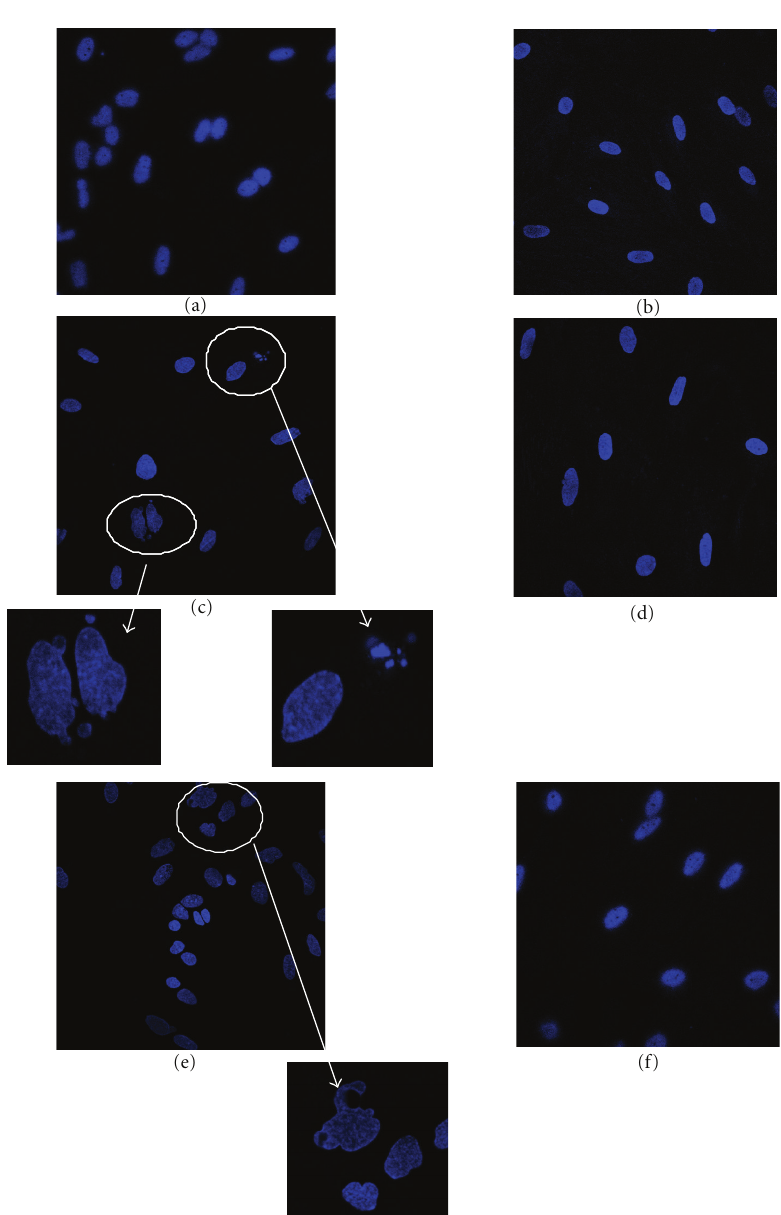
Figure 5: E ff ect of treatment with 5 μ M resveratrol on ethanol-induced nuclear damage in primary cultures of astrocytes. Nuclei were labeled with Hoechst 33342 as described in Section 2. Figure 5 shows representative fluorescent microscope images evidencing the nuclear morphology of astrocytes in control conditions (a), exposed to 5 μ M resveratrol for 3 days (b), exposed to 20mM ethanol for 3 days without (c) or with a recovery period (e), or exposed to 20mM ethanol for 3 days, with pre- and cotreatment with 5 μ M resveratrol (d) and followed by a recovery period (f). In zoom sections of micrographs, arrows point nuclear blebs and nuclear fragmentation. All images are representative fields of at least three independent experiments carried out in